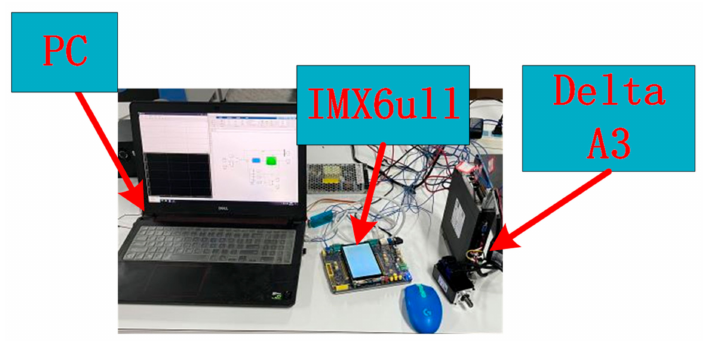
Figure 17. Physical validation platform.